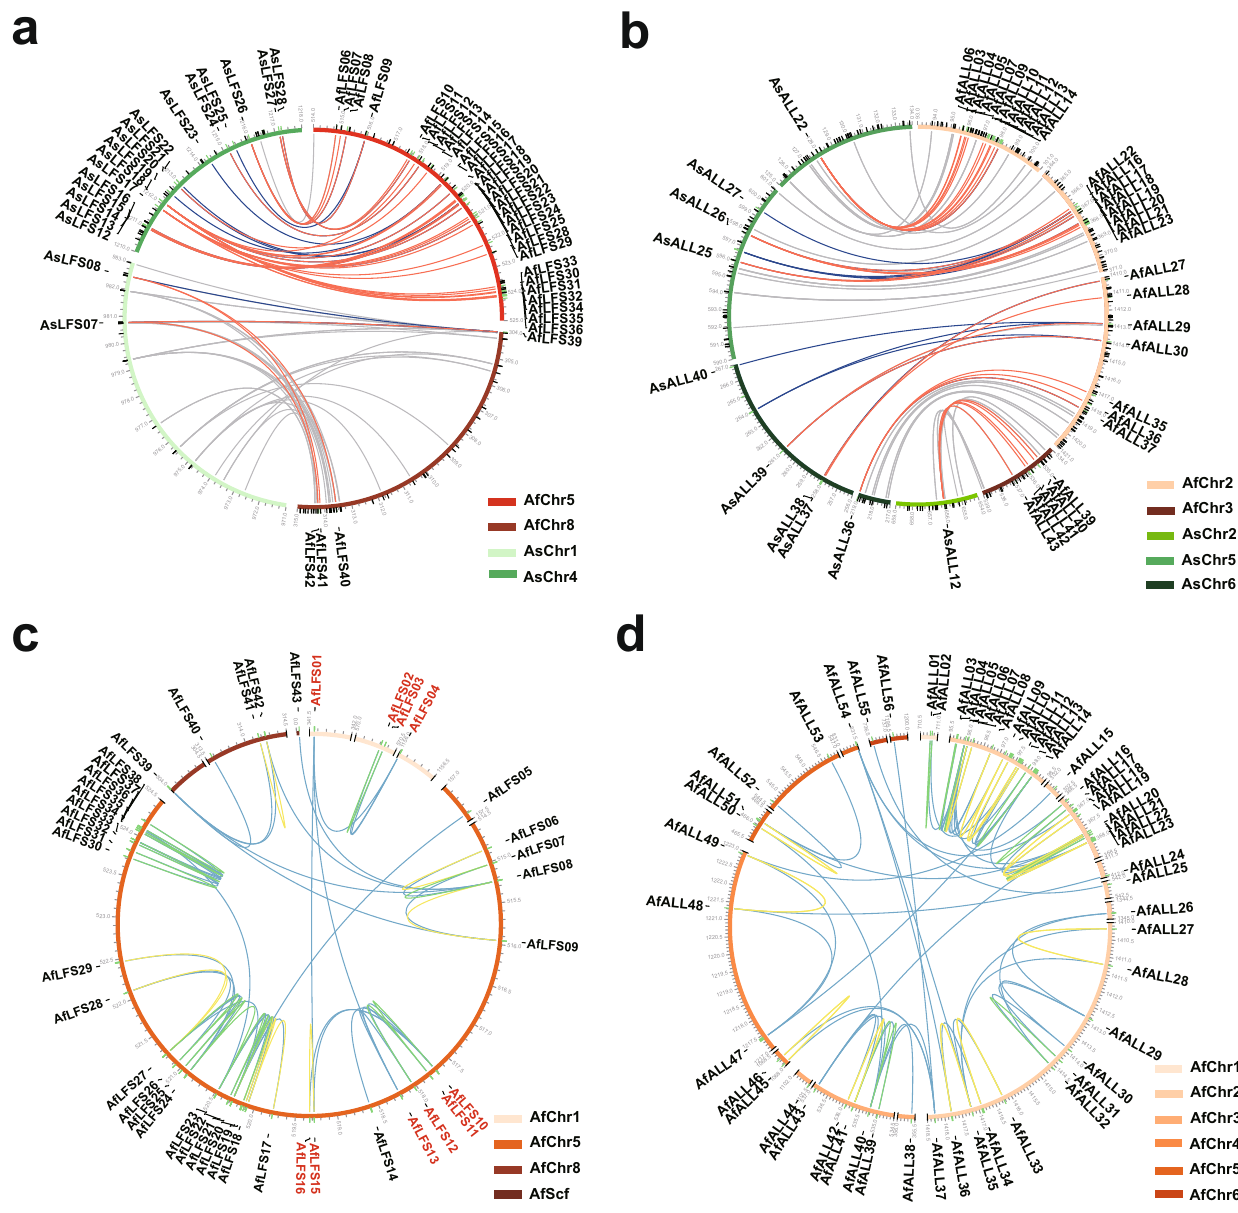
Fig.5|Independentexpansionsof LFS and ALL genefamiliesbetweenbunching onionandgarlic.a , b Themicro-collinearityrelationshipof LFS ( a )and ALL ( b )in A. fi stulosum and A. sativum . The red lines indicate genes were expanded in A. fi stu- losum ,thebluelinesindicategeneswereexpandedin A.sativum ,andthegraylines indicate other genes which show collinearity relationships. c , d The gene